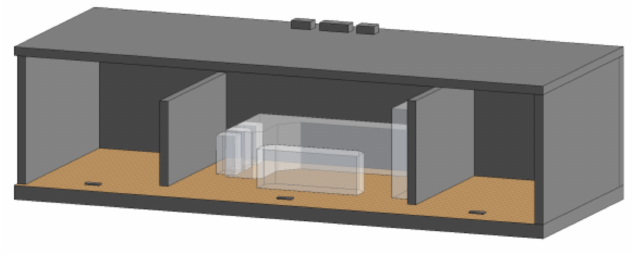
Figure 6. Simplified Revit model ready for CFD